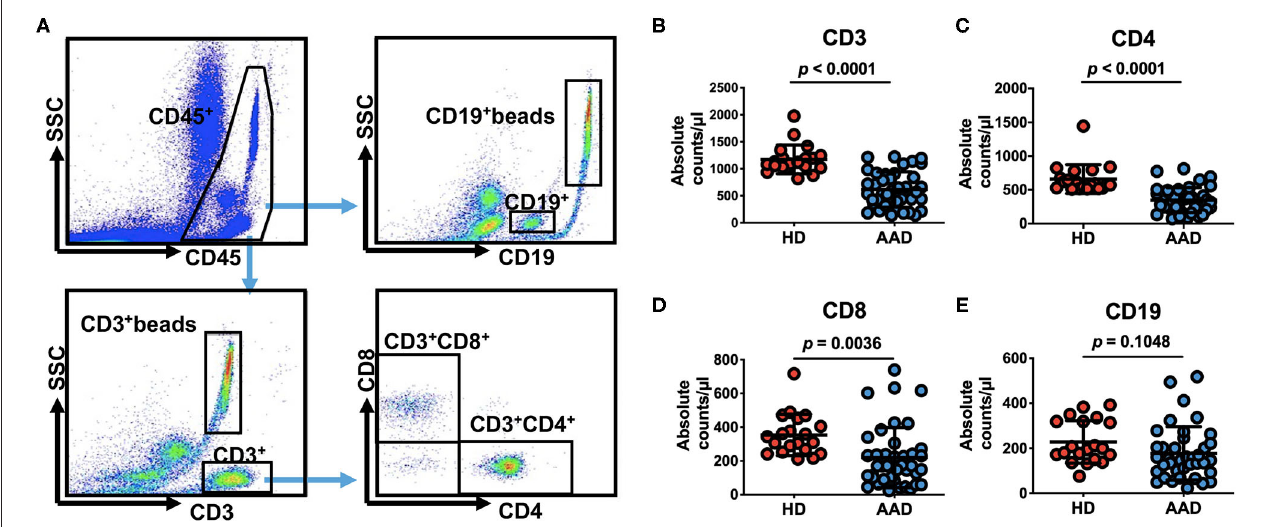
FIGURE 1 | Pre-operative peripheral blood lymphocyte subsets count in 40 patients undergoing surgical repair of type A aortic dissection and 20 healthy donors. (A) Quantitation of numbers in a lysed whole-blood, that is, all lymphocytes presented in the lymphocyte gate identified by CD45 fluorescence and side scatter on flow cytometry and consisting mainly of CD3 + , CD4 + , CD8 + , CD19 + cells and their corresponding beads are examined. (B–E) Comparison of pre-operative peripheral blood lymphocyte subsets counts between AAD patients and HDs (data shown as means ± SD). CD3 + beads, the beads corresponding CD3 + cells, CD19 + beads, the beads corresponding CD19 +